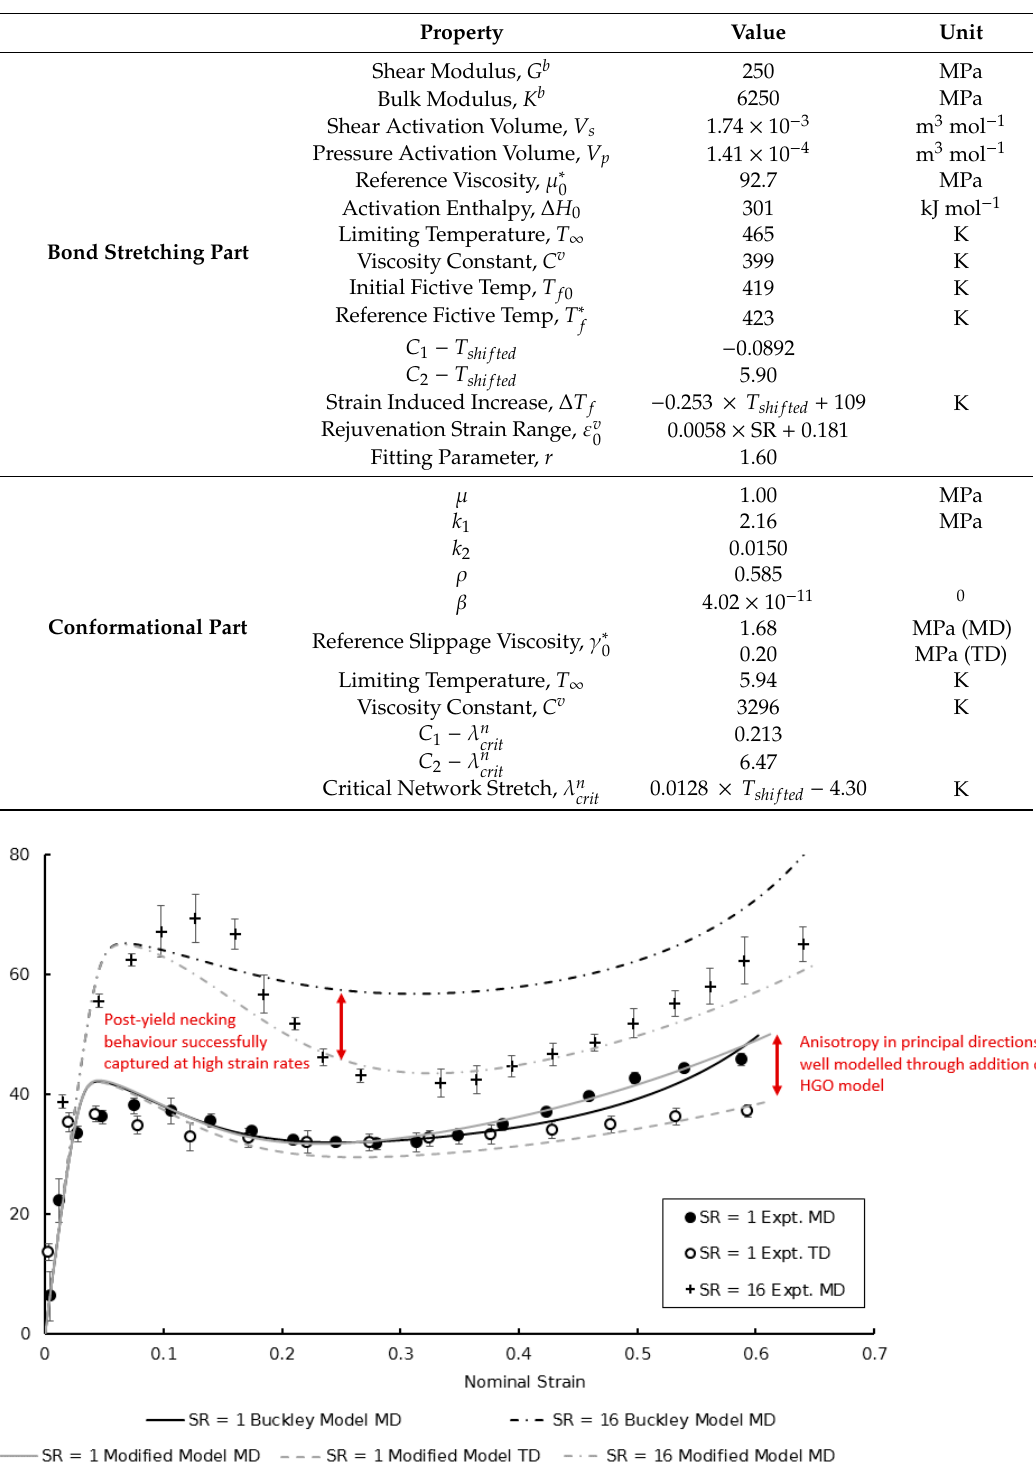
Table 3. Characterised constants for modified Buckley material model through biaxial testing methods.